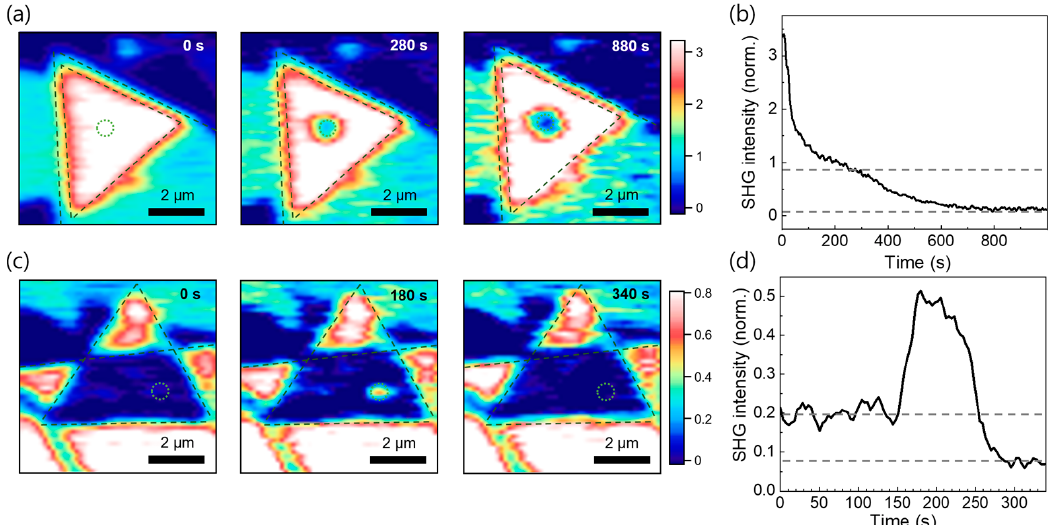
Figure 5. ( a ) SHG maps of the twisted bilayer with constructive interference (i.e., with θ twist = 0) at different times ( t = 0, 280, 880 s). The ablation laser was switched on at t = 0 and focused on the dashed circular area; ( b ) SHG intensity vs. time at the ablation laser spot position in ( a ). The intermediate status was observed owing to the layer-by-layer etching; ( c ) SHG maps for the twisted bilayer with destructive interference (i.e., with θ twist close to 60°) at different times ( t = 0, 180, 340 s); ( d ) SHG vs. time for the laser irradiation at the laser spot position in ( c ). The abrupt increase in the SHG signal indicates that the top layer has been removed by the ablation.